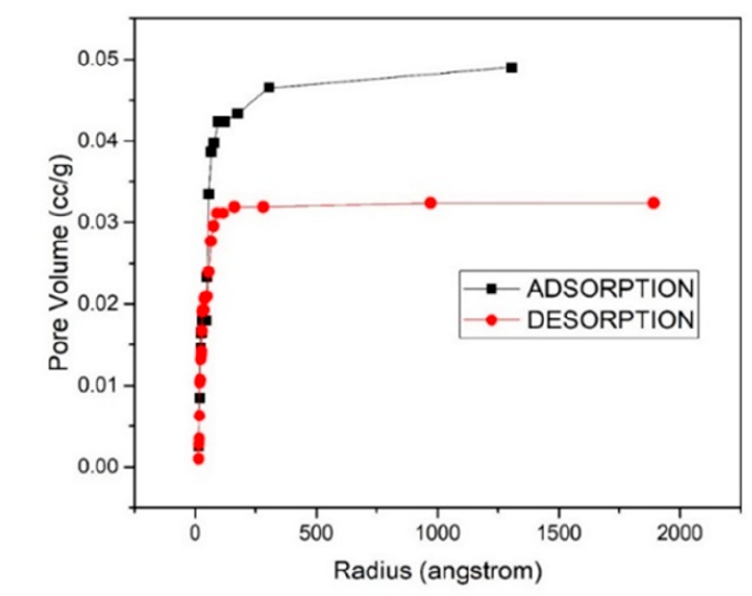
Figure 5. Adsorption-Desorption Curve 6% PVP.